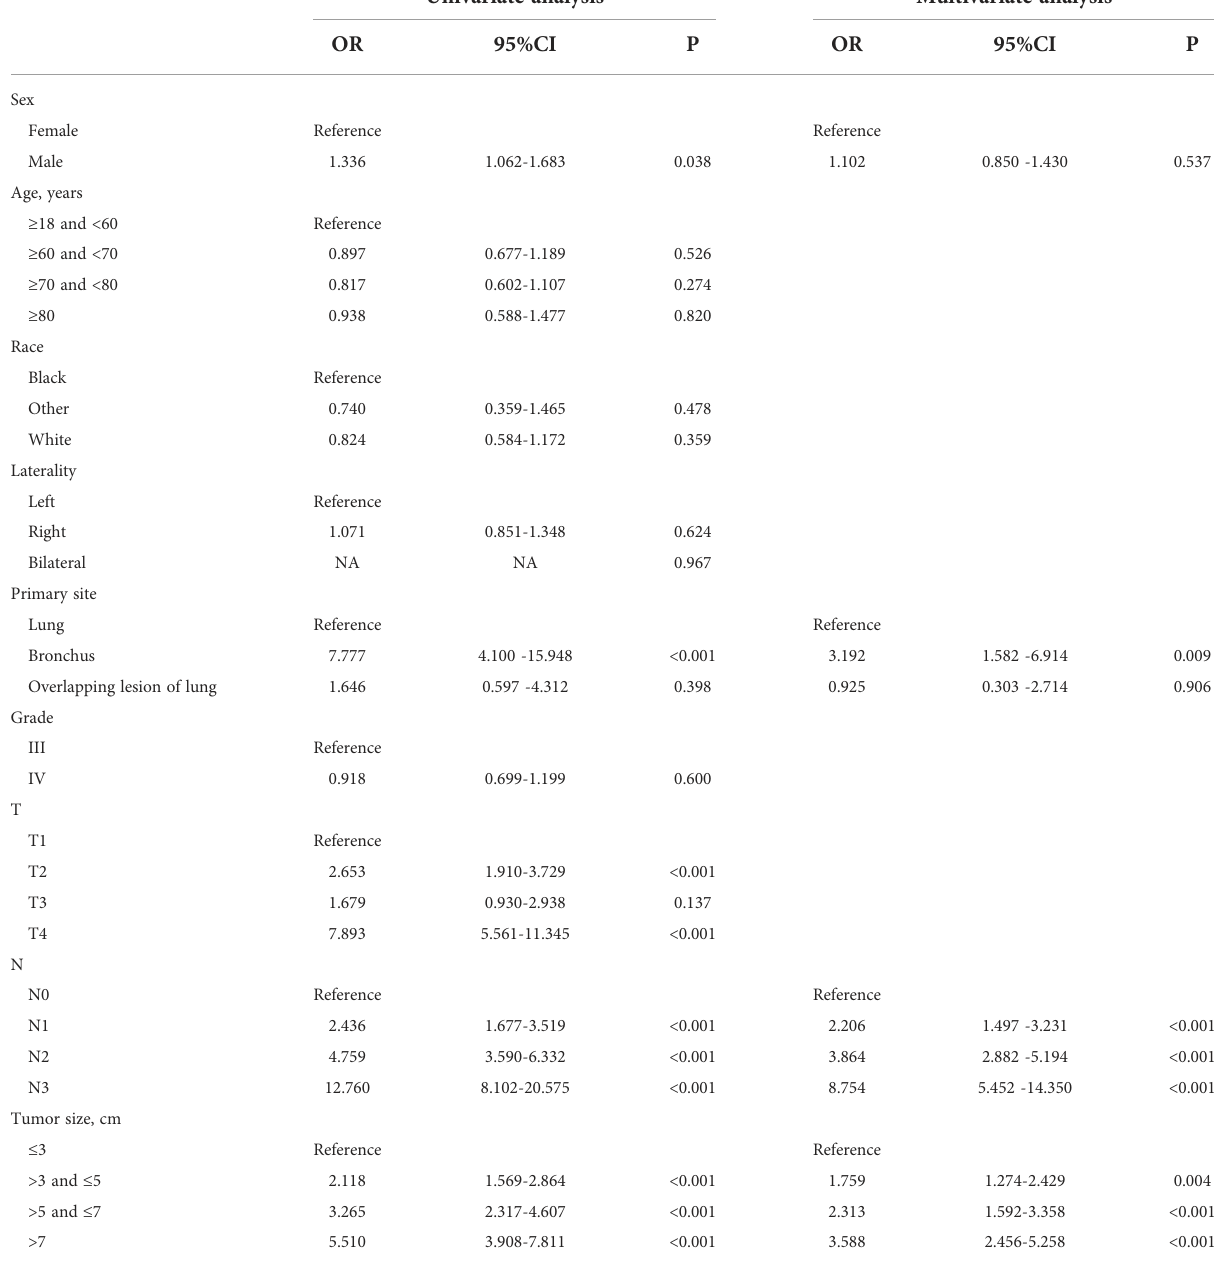
TABLE 3 Analyses of distant metastasis in LCNEC patients using univariate and multivariate logistic